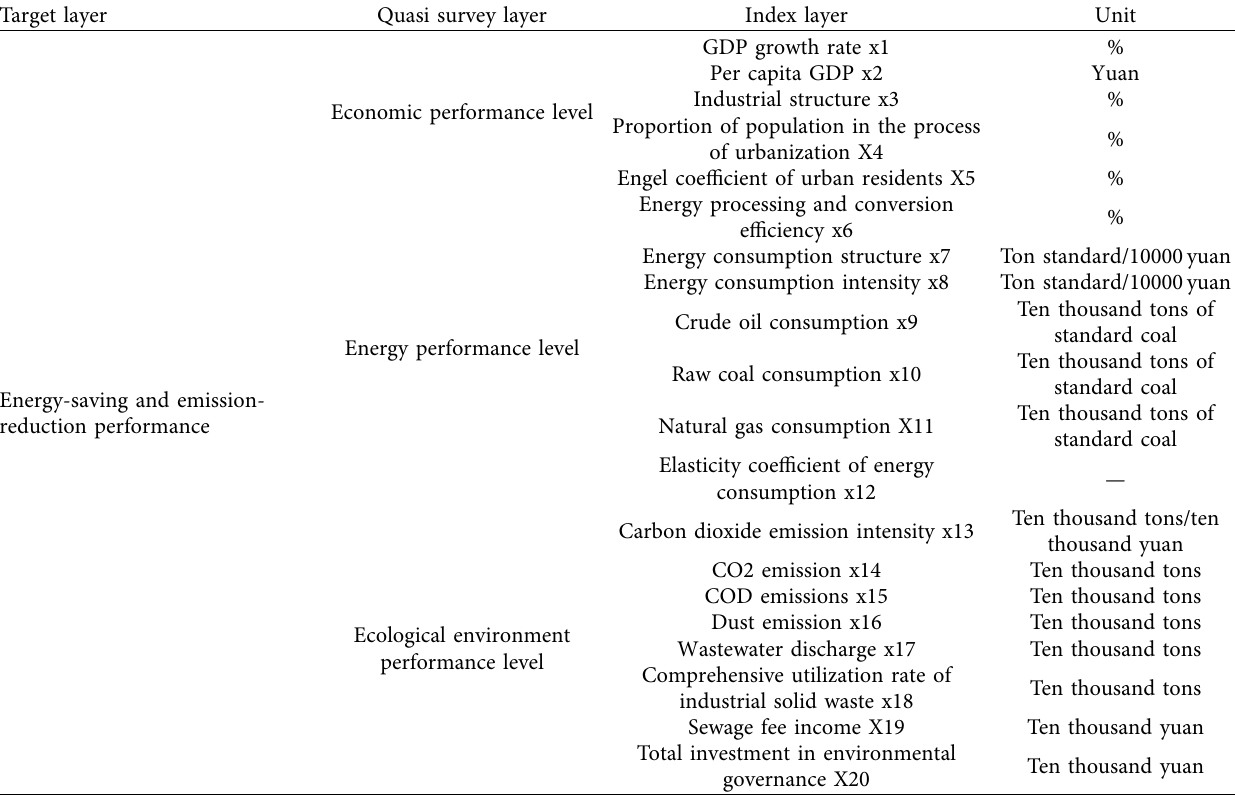
Table 1: Performance evaluation indicators of reducing consumption of energy of low-carbon economy.